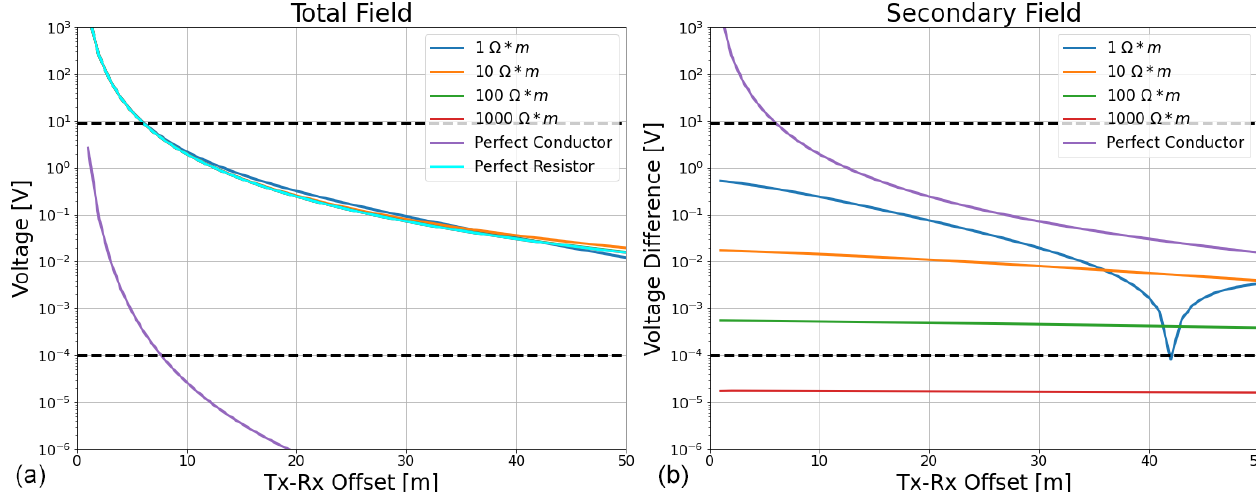
Figure 3. (a) The absolute value of the R x voltage measured by a horizontal coplanar (HCP) configuration, corresponding to the change in the total vertical magnetic field, resting on a half-space of variable conductivity as a function of T x - R x offset. All R x electronic parameters (resistance, inductance, capacitance, amplifier gain) are as indicated in Fig. 4, with a T x frequency of 1680Hz, a current of 2.0A, and T x and R x coil areas of 0.29m 2 each with 100 turns. The dashed horizontal lines indicate the upper (9.0V) and lower (0.1mV) limits of the R x amplifier power supply and DMM resolution, respectively. (b) Difference between free-air and half-space voltages (effectively the amplitude change of the secondary field) for an HCP configuration with all parameters identical to those shown in (a)